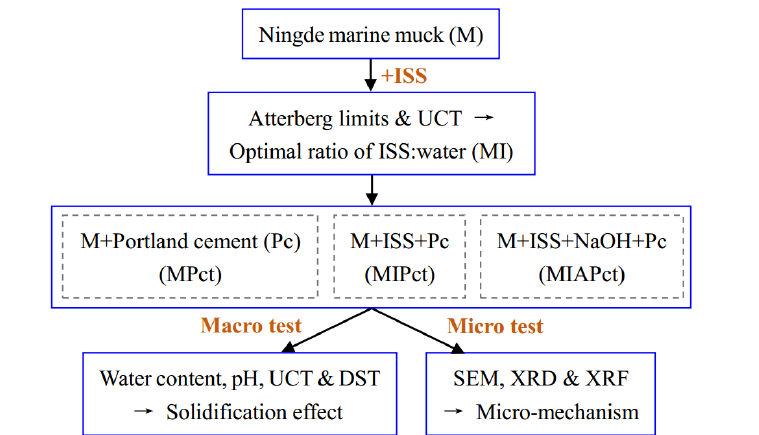
Figure 3. Procedure of